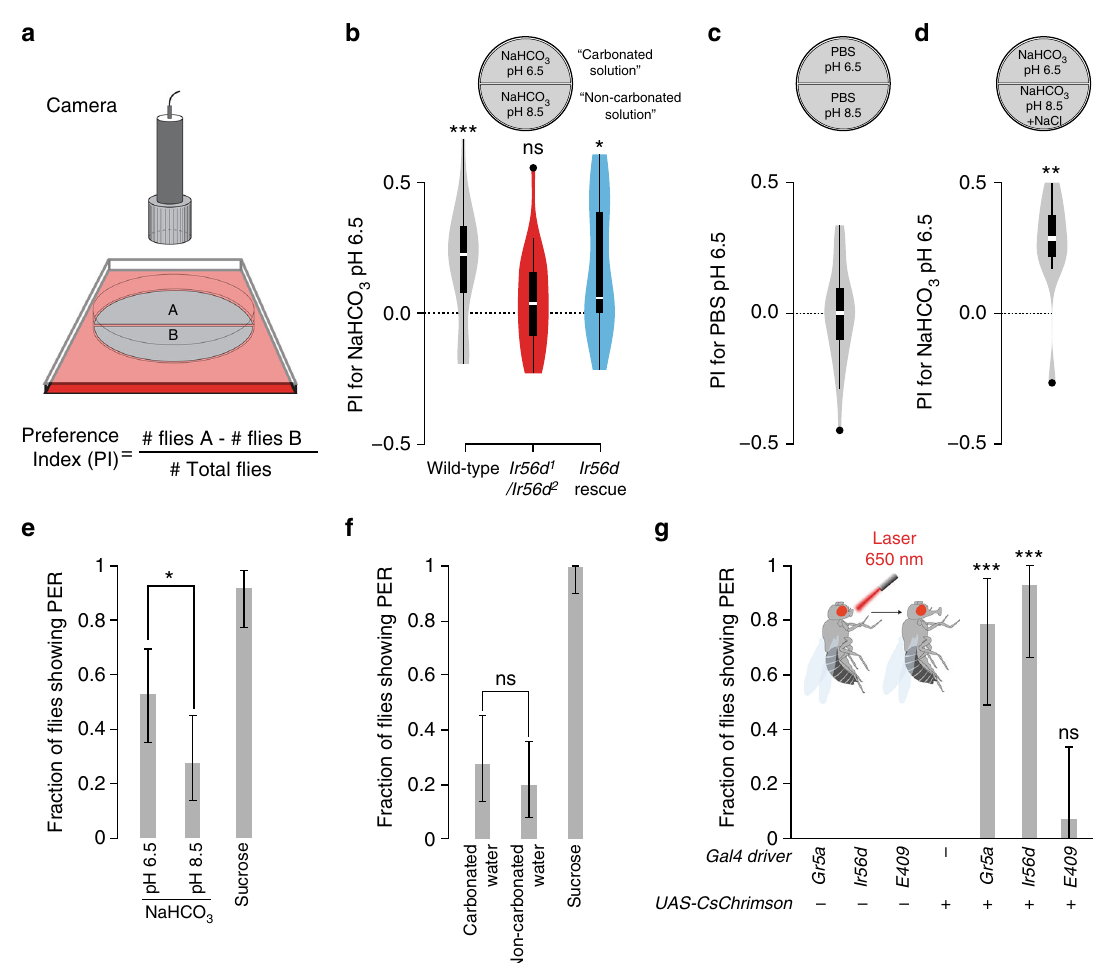
Fig. 7 Carbonation promotes IR56d-dependent feeding behaviours: a Schematic of the two-choice positional preference arena assay. Flies can choose to feed from two substrates comprising stacks of blotting paper soaked in different tastant solutions on opposite sides of a 94 mm diameter Petri dish. Fly position was quanti fi ed automatically and used to calculate a Preference Index (PI) as indicated below the scheme. b Two-choice assay showing the preference of the indicated genotypes for a carbonated solution (100 mM NaHCO 3 pH 6.5) over a control non-carbonated solution (100 mM NaHCO 3 pH 8.5). Genotypes: w 1118 ( n = 21 arenas; 70 – 80 fl ies per arena); Ir56d mutant: w;Ir56d 1 /Ir56d 2 ( n = 21 arenas); Rescue: w;Ir56d 1 ,UAS-Ir56d/Ir56d 2 ;Ir56d-Gal4/ + ( n = 14 arenas) . ns non-signi fi cant, * P < 0.05, ** P < 0.01, *** P < 0.001 (Wilcoxon signed rank test ( H = 0)). c Two-choice assay showing the preference 0 of w 1118 fl ies ( n = 24 arenas) for a PBS pH 6.5 solution vs. a PBS pH 8.5 solution. d Two-choice assay showing the preference of w 1118 fl ies ( n = 10 arenas)